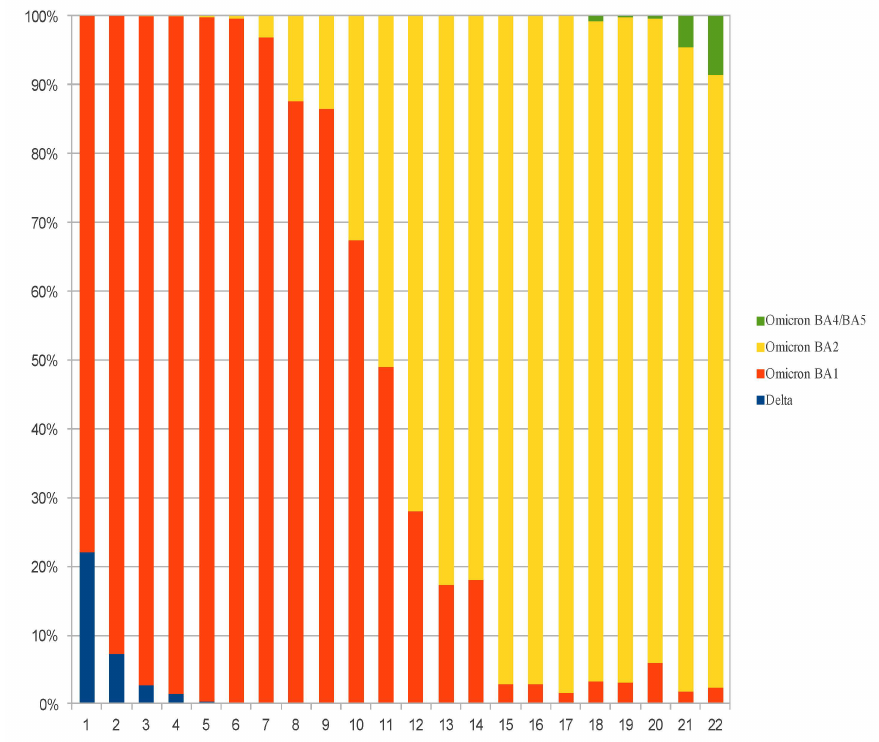
Figure 1. Weekly distribution of each variant in Asurias according Spike